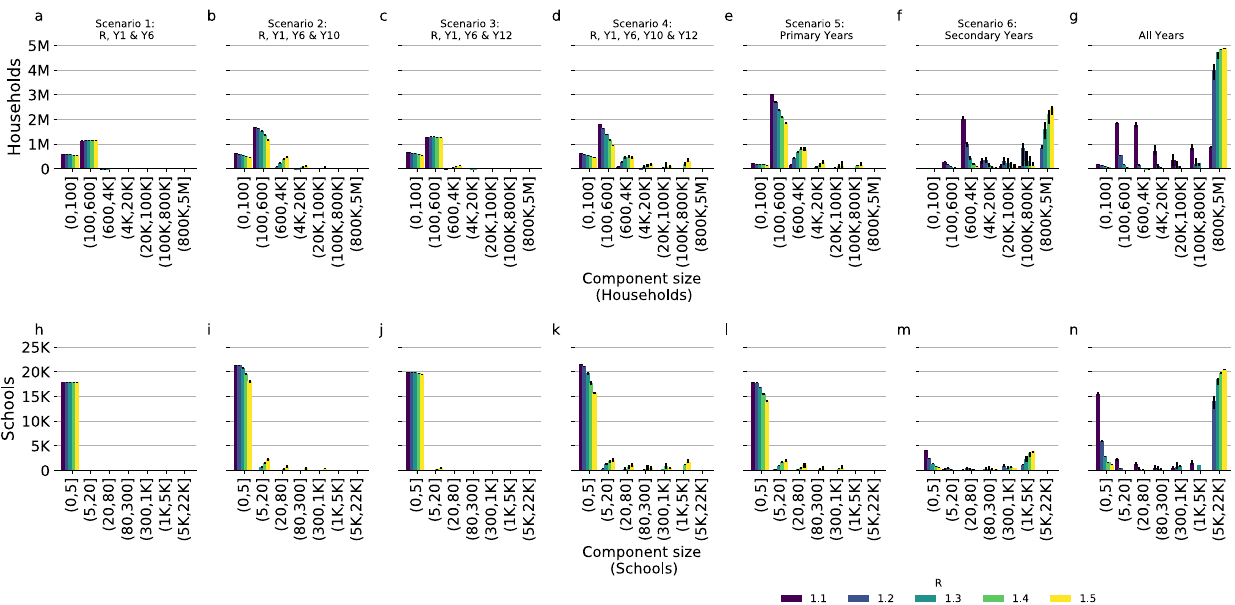
Fig. 5 Connected component distributions. The distribution of component sizes of the binary outbreak networks generated for school reopening scenarios and R values of 1.1 – 1.5 (indicated by colour). By households, i.e. the number of households in a component size in each bin, panels a – f show reopening scenarios 1 – 6, respectively, and panel g shows the network with all school years in attendance. By school, i.e. the number of schools in a component size in each bin, panels h – m show reopening scenarios 1 – 6, respectively, and panel n shows the network with all school years in attendance. The bars show the median and error bars show 90% credible intervals for 1000 realisations of binary outbreak networks.